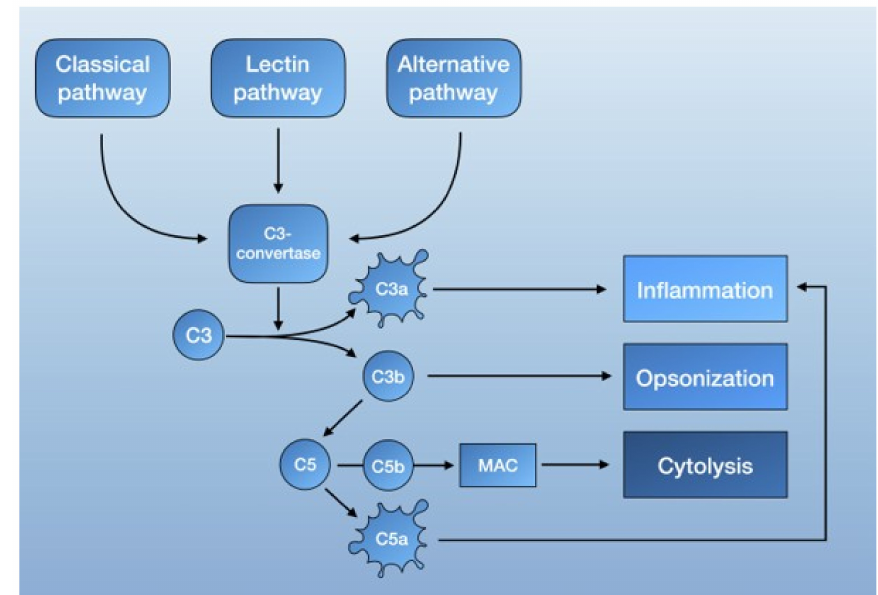
Figure 1. Schematic overview of the complement